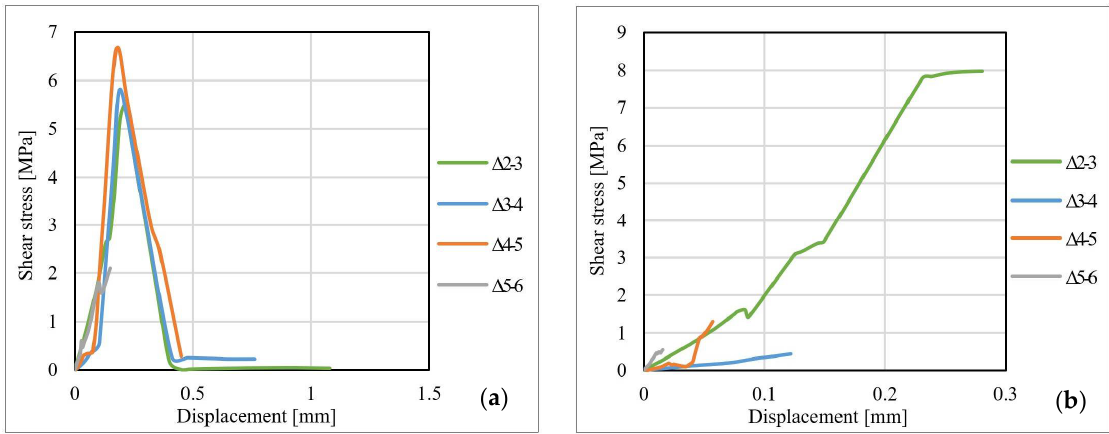
Figure 14. Bond–slip curves for specimens: ( a ) S-M514-30-3-I and ( b ) S-M514-330-3-I.